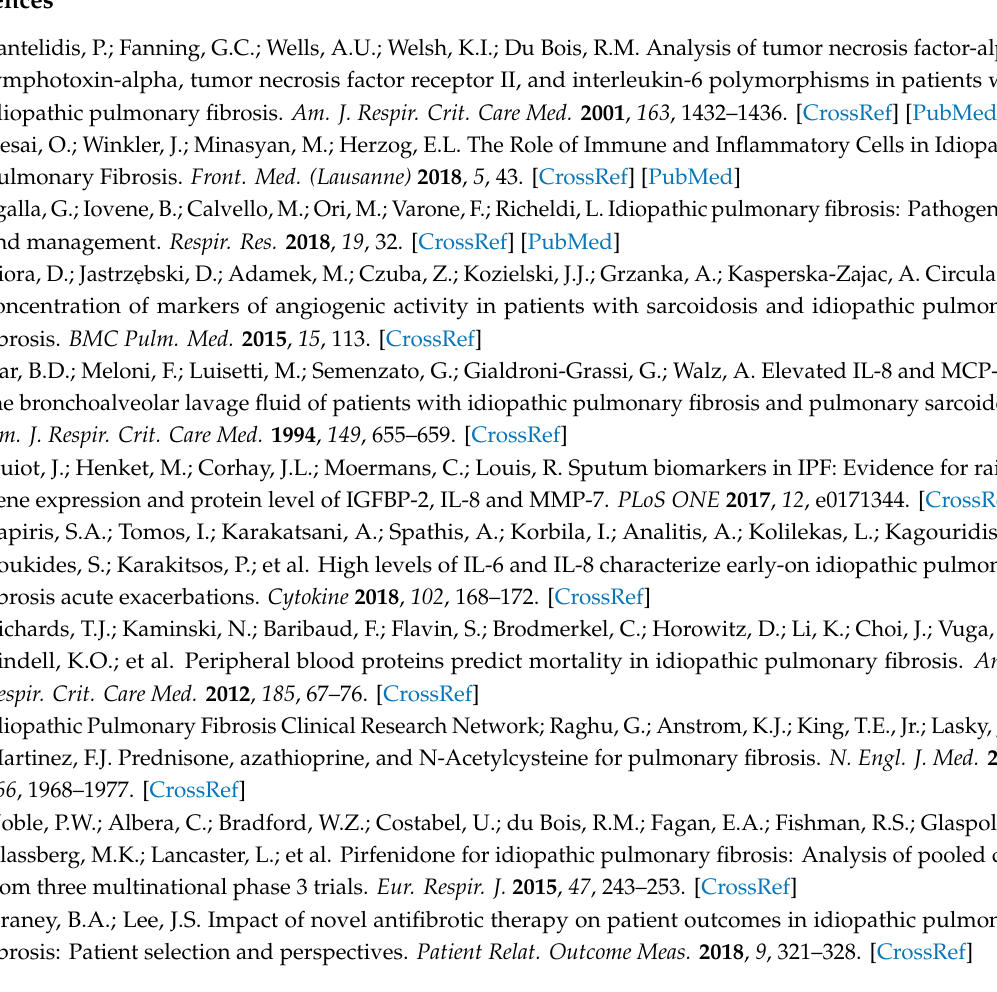
Table S1: Clinical data of patients with IPF with exhaled breath condensate IL-6 concentration decrease and increase following six months of treatment with pirfenidone, Table S2: Clinical data of patients with IPF with exhaled breath condensate VEGF-A concentration decrease and increase following six months of treatment with pirfenidone, Table S3: Comparison of clinical data of patients with IPF who demonstrated simultaneous IL-6 and VEGF-A increase and those who showed simultaneous IL-6 and VEGF-A decrease in EBC following six months of treatment with